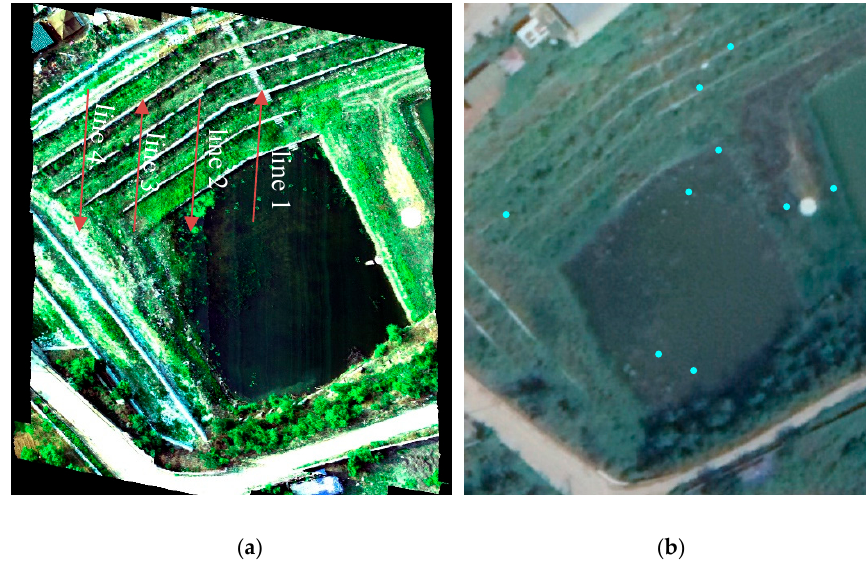
Figure 7. Comparison of the ( a ) mosaicked image by stitching Figure 6b,d,f,h with the ( b ) satellite image acquired on 4 September 2018, from Google Earth.